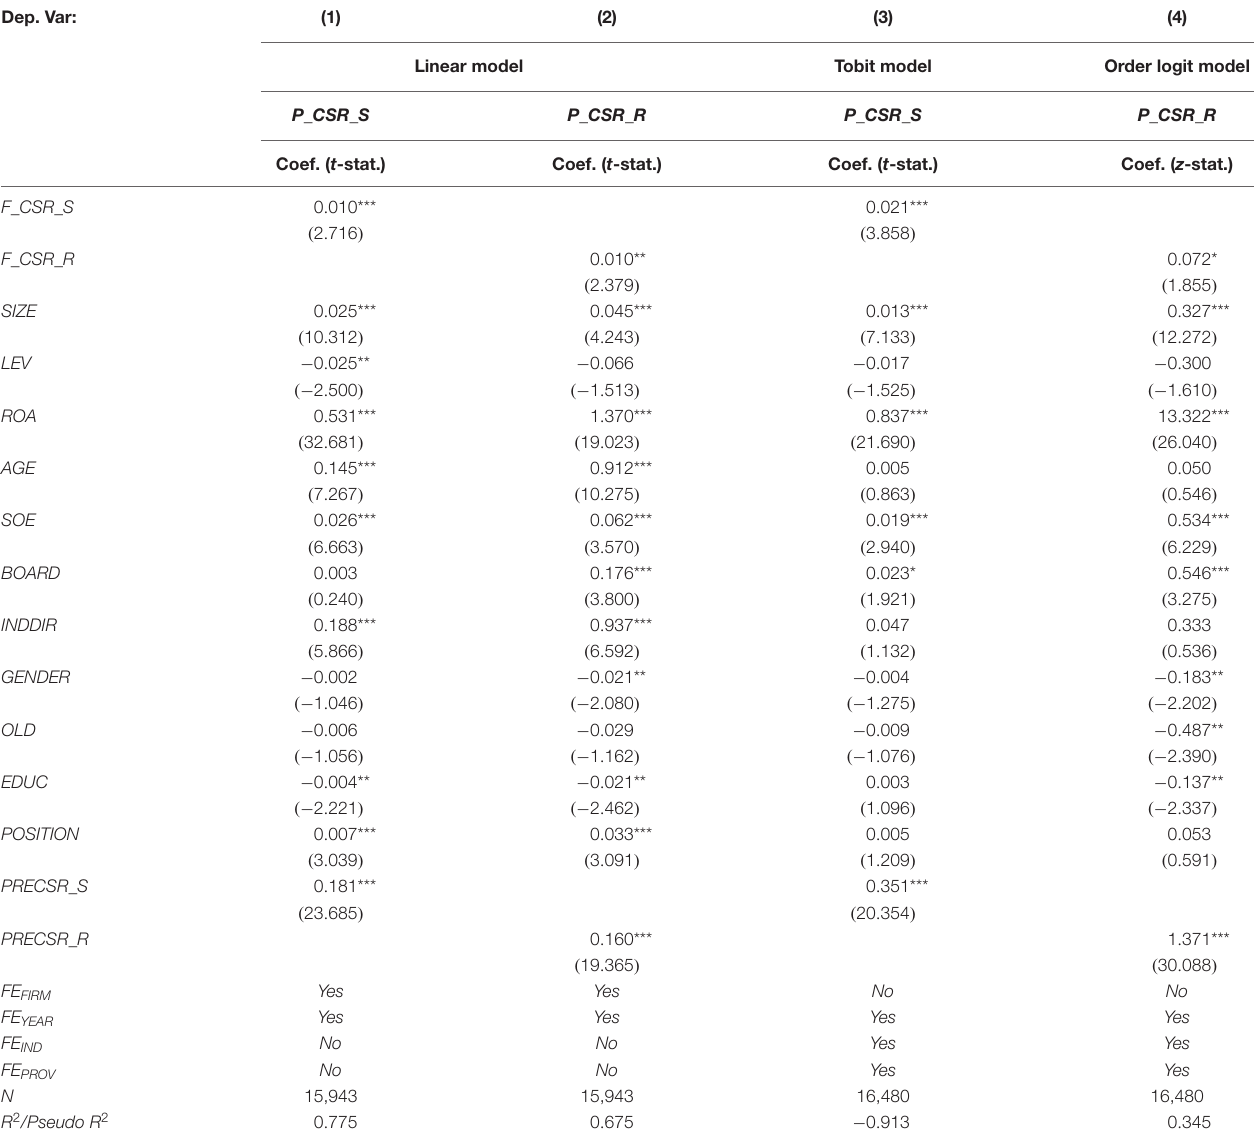
TABLE 5 | Regression results of Model